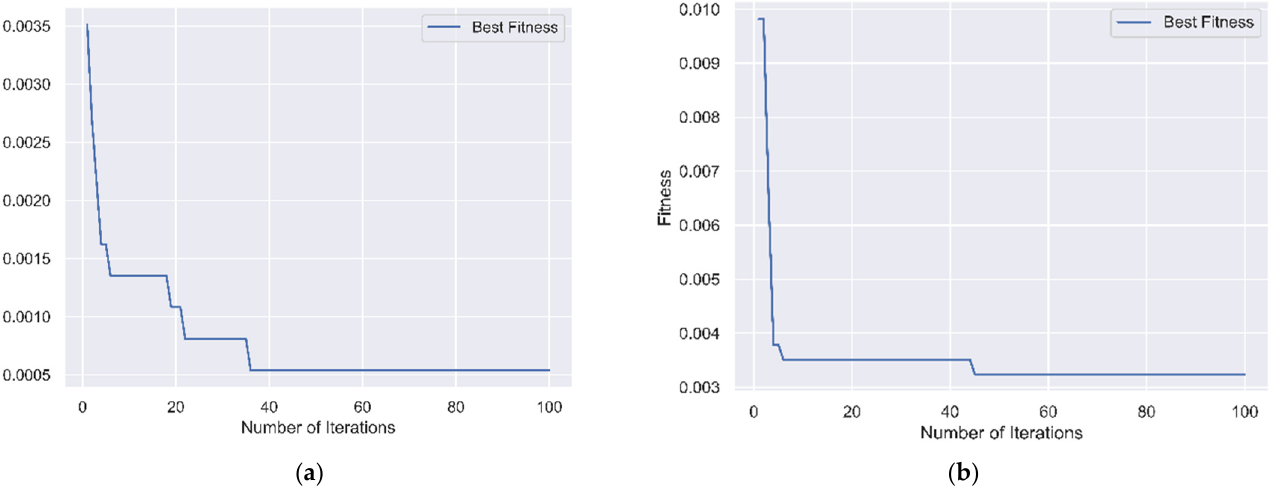
Table 6. Number of selected